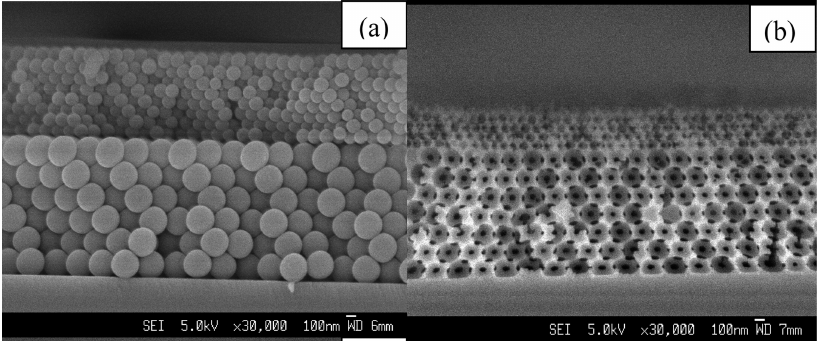
Figure 8. ( a ) SEM images of polystyrene opaline structure and ( b ) titanium dioxide inverse opal structure [116]. Adapted with permission from Langmuir, 24, 1796–1800. Copyright (2008) American Chemical Society.